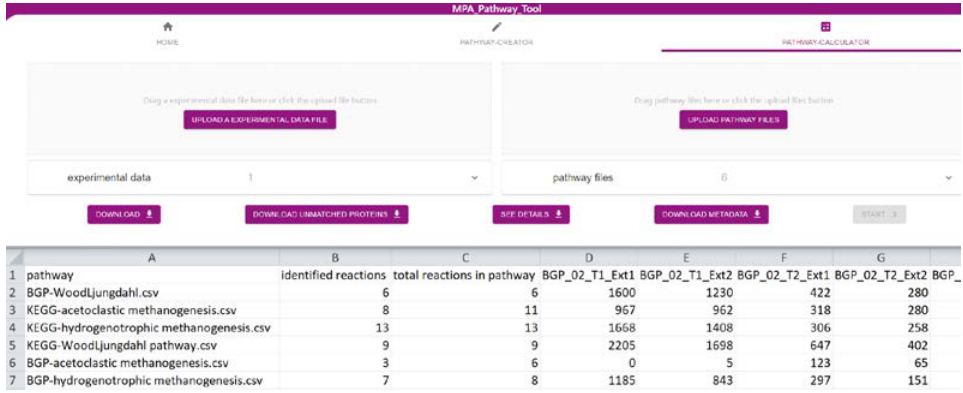
Figure 1. Screenshot of the ‘Pathway-Creator’ of the MPA_Pathway_Tool (details in Section 2.1).